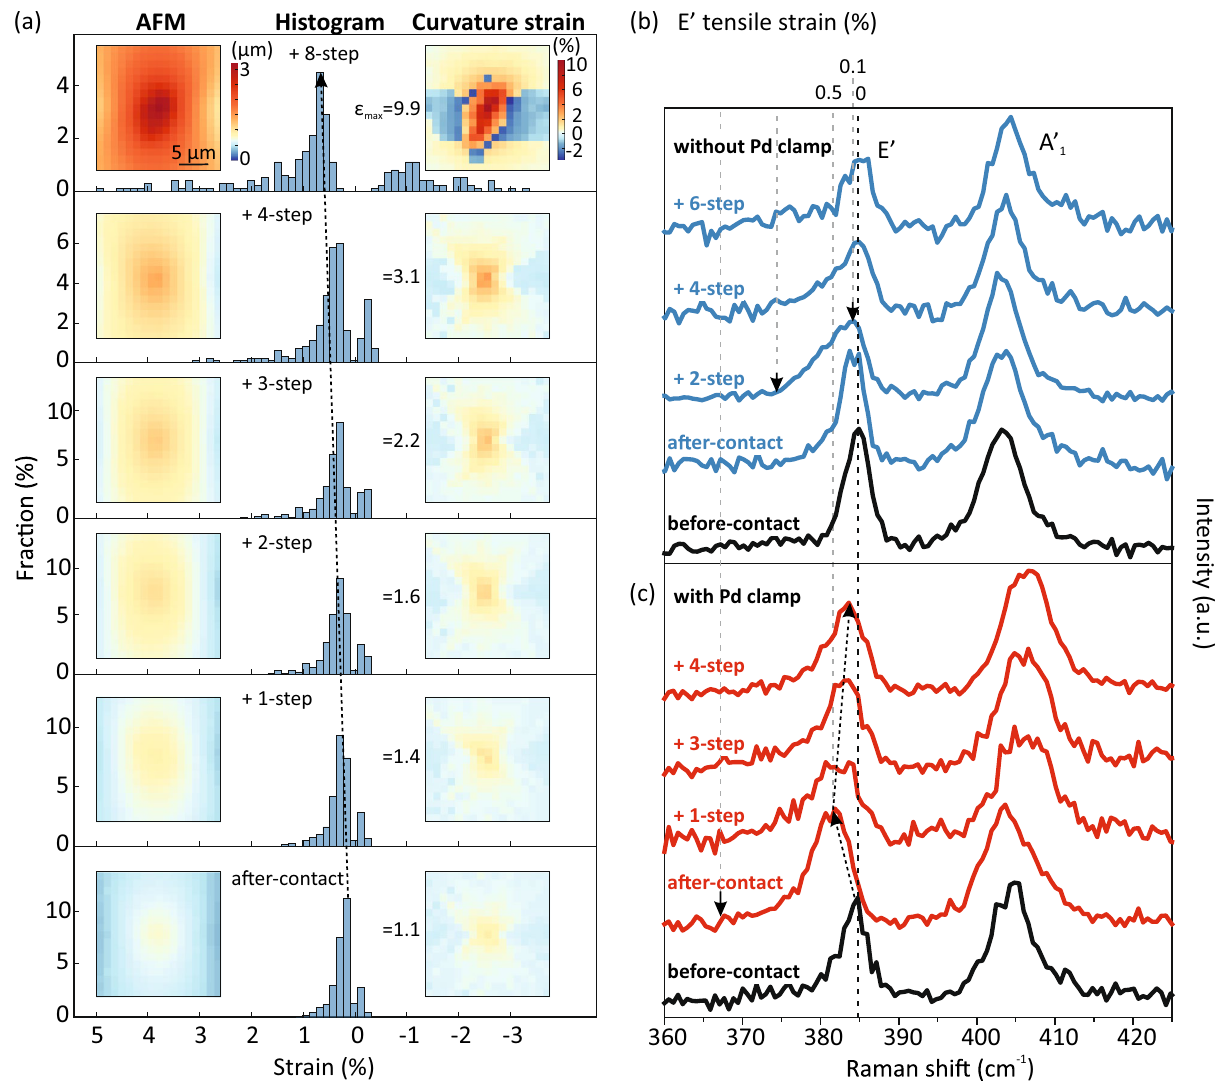
Figure 4. Characterization of strain distribution. ( a ) Calculation of the curvature-induced strain distribution based on the AFM topography images measured on the polyimide film before transferring the 2D material that were shown in Fig. 3. ( b , c ) Raman spectra taken at the indented center of monolayer MoS 2 transferred on polyimide film with increasing the number of gear steps. ( b ) is with and ( c ) is without a Pd (Figs. 2e, 5a). In the high strain case after the gearbox rotation, the indentor exerts force on the whole polyimide film, and a tent-like structure is formed (Fig. 2e, 5b). At such high strain, the film is tightened and becomes more sensitive to the indentor height. The deformation of the 2D material depending on V st is characterized by measuring the z movement of the STM tip in the constant current mode. When the indentor pushes up the graphene/polyimide film, the STM tip retracts accordingly to maintain the current constant, as shown in Fig. 5c. For the relaxed condition, the STM-tip retracts (37 nm) when V st increases from 0 to 75 V. However, in the tented case, a larger V st -dependent sample height change (85 nm) is observed when V st increases from 0 V to 80 V. The sample height change dependence on V st can be controlled reversibly (Fig. S1). The absence of hysteresis in the height change suggests that the polyimide film is still flexible even at ∼ 4.8 K, and the slippage between indentor and polyimide film is negligible. On the other hand, the relaxed graphene/polyimide film is easily affected by external stimuli in comparison with the tented case. Figure 5d shows the change in STM-tip height with increasing V b from 0.3 to 0.7 V. The recorded heights are 0.2, 1.8, and 7.3 nm for the relaxed, tented, and supported cases, respectively. In compari- son with the supported area where the STM-tip height is determined solely by the electrostatic force, a more considerable STM-tip height change in the suspended area is induced by the additional height change of the graphene/polyimide film pulled up by the STM-tip (via the van der Waals forces) 54 . A much larger height change is observed in the relaxed case, since the polyimide film has a lower tension, as shown in Fig. 5a, b. The gate controllability is confirmed by measuring the dependence of the STM tip height on gate voltage (V g ). As V g increases from 0 to 20 V, the STM-tip retracts in a constant current mode indicating that charge